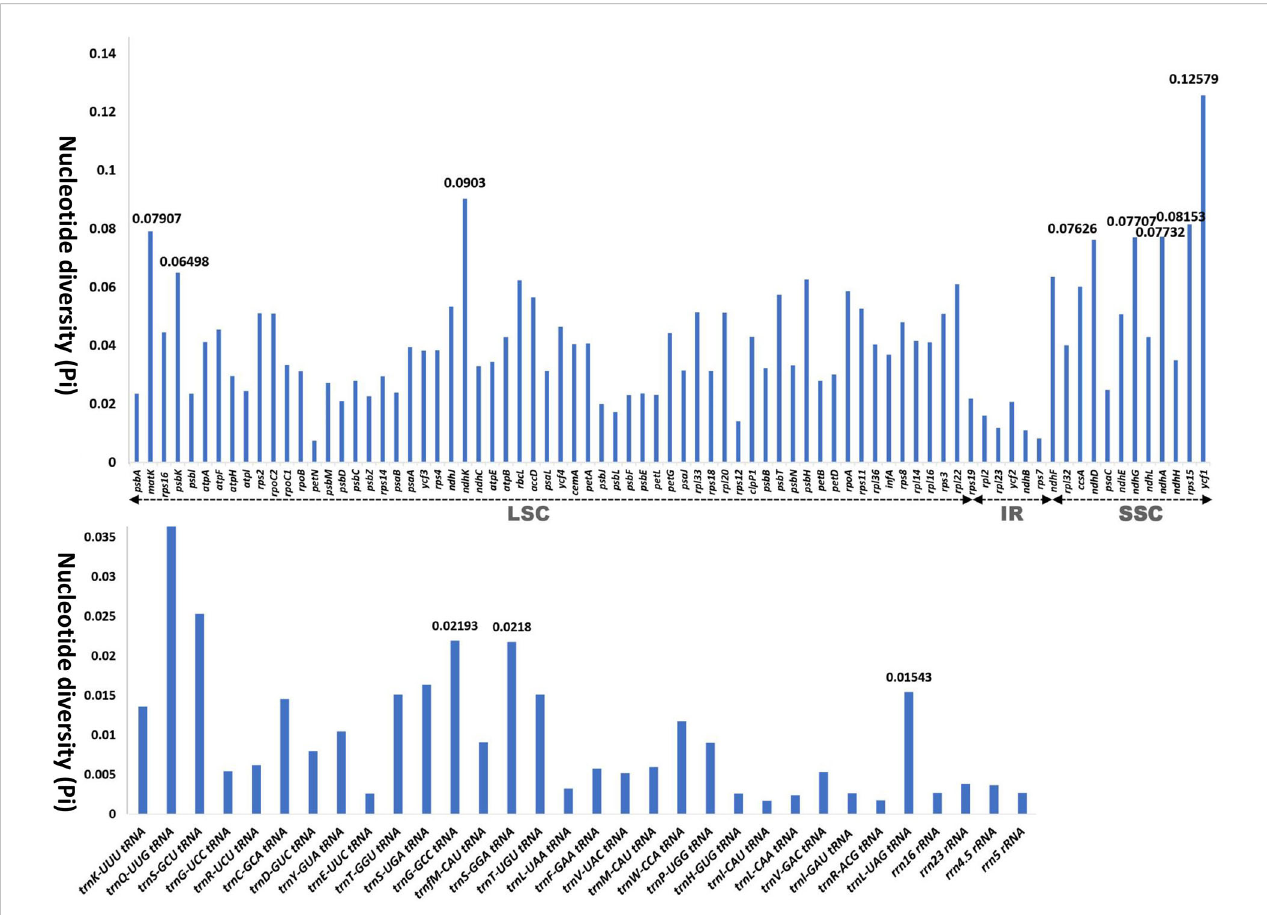
FIGURE 3 Graphs showing the variation in nucleotide diversity (Pi) in the protein-coding region, transfer RNA, and ribosomal RNA in 24 representative taxa of